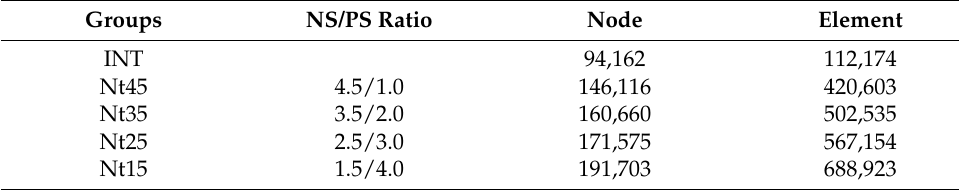
Table 3. The elements and nodes of the five finite element models.